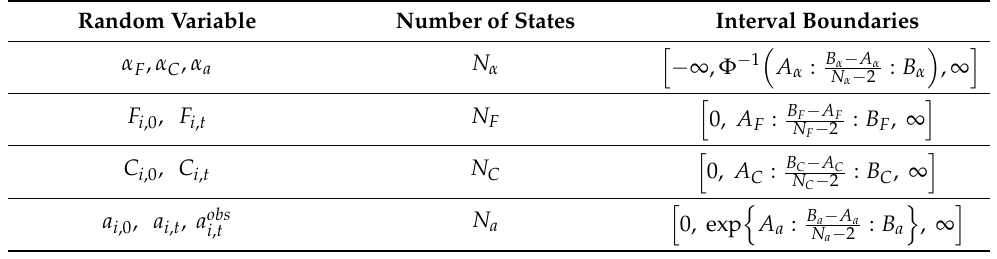
Table 1. Discretization schemes of random variables in the established hierarchical DBN